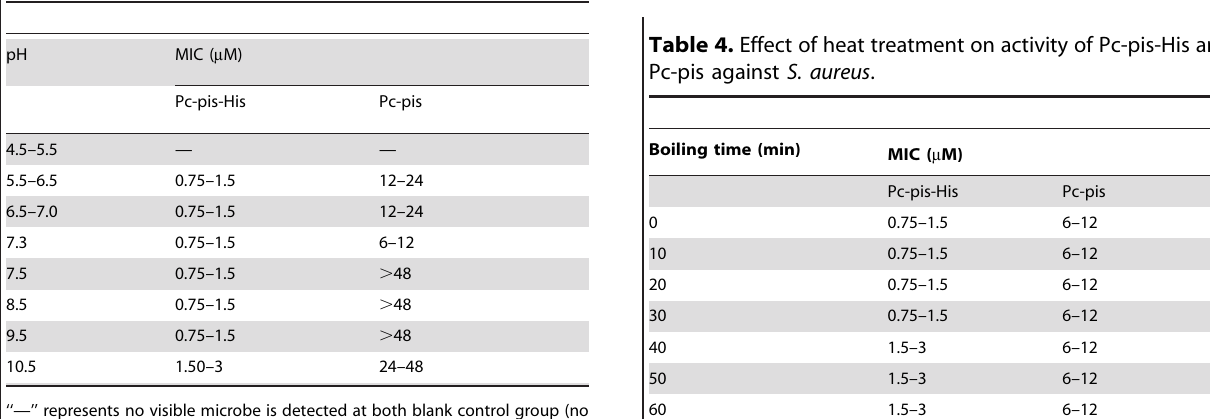
Table 3. Effect of acid and alkali on activity of Pc-pis-His and Pc-pis against S. aureus .